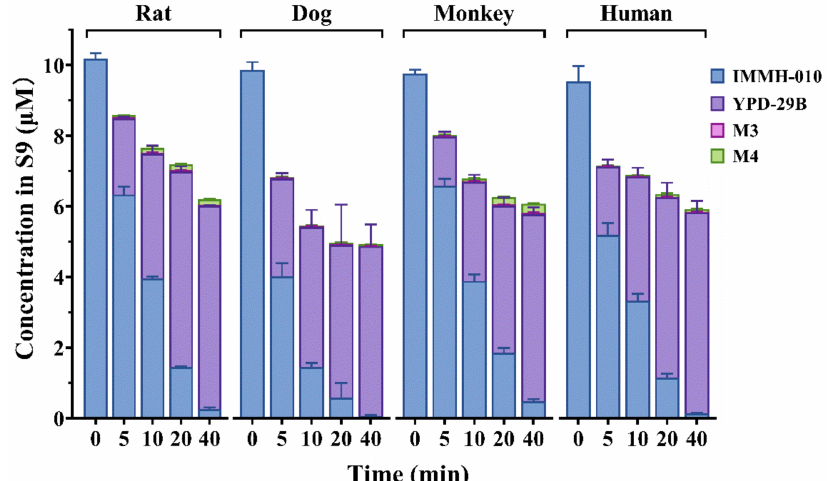
Figure 4. IMMH-010 metabolism in rat, dog, monkey, and human liver S9 fractions. IMMH-010 (10 µ M) was incubated with liver S9 homogenate protein (0.5 mg protein/mL) and an NADPH regenerating system in a final volume of 0.2 mL Tris-HCl buffer (50 mM, pH 7.4) containing 5 mM MgCl 2 . IMMH-010 metabolism in the liver has interspecies similarities. Data are expressed as mean ±